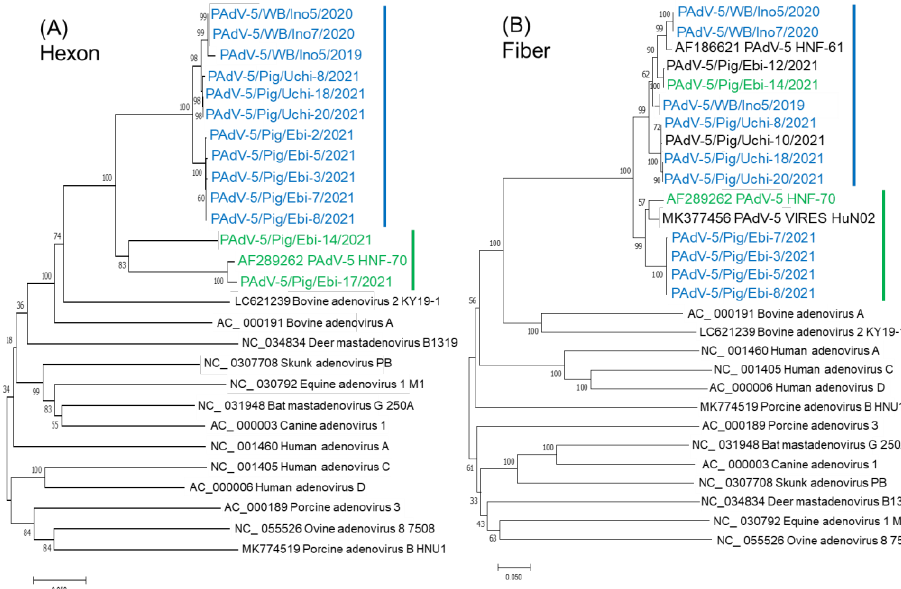
Figure 5. Phylogenetic analysis based on partial nucleotide sequences of the hexon ( A ) and fiber ( B ) coding region of PAdV-5s and other adenoviruses. The trees were constructed according to the neighbor-joining method in MEGA7 with 1000 bootstrap values. The bar represents a corrected genetic distance. Strains clustered with Ino5 and HNF-70 in the hexon tree were colored in blue and green, respectively.